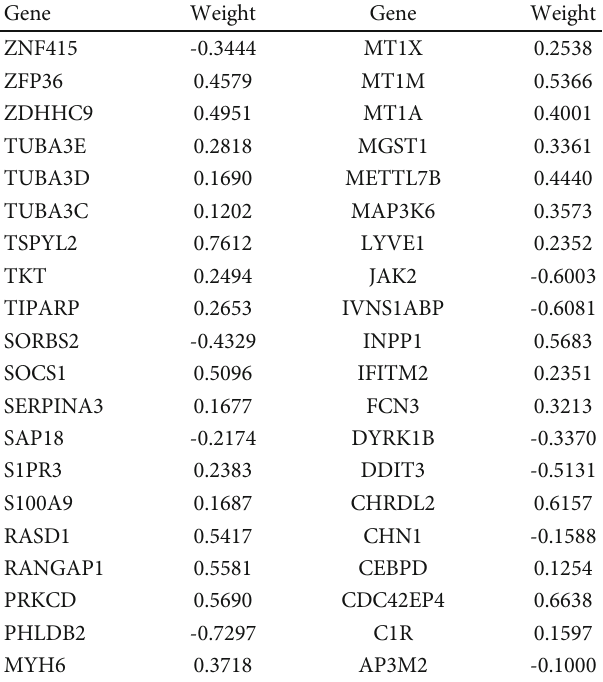
Table 2: Feature gene